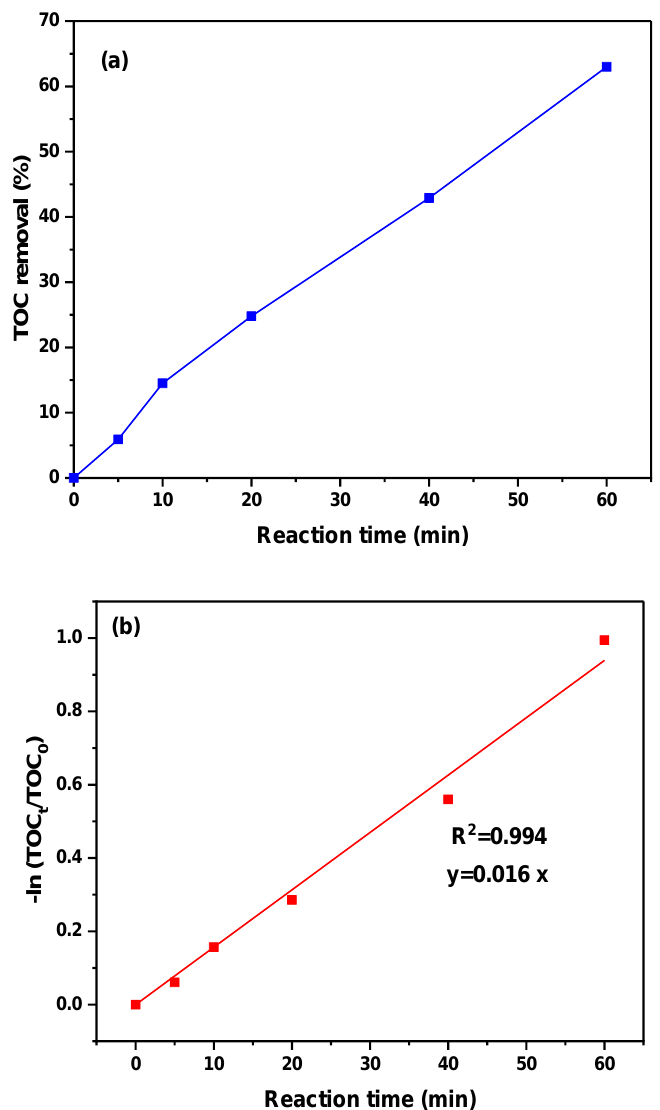
Figure 11. Mineralization percentage ( a ) and rate ( b ) of GBP in the Cu-TiO 2 /VUA process (GBP = 10 mg/L, pH = 8, catalyst = 0.4 g/L).